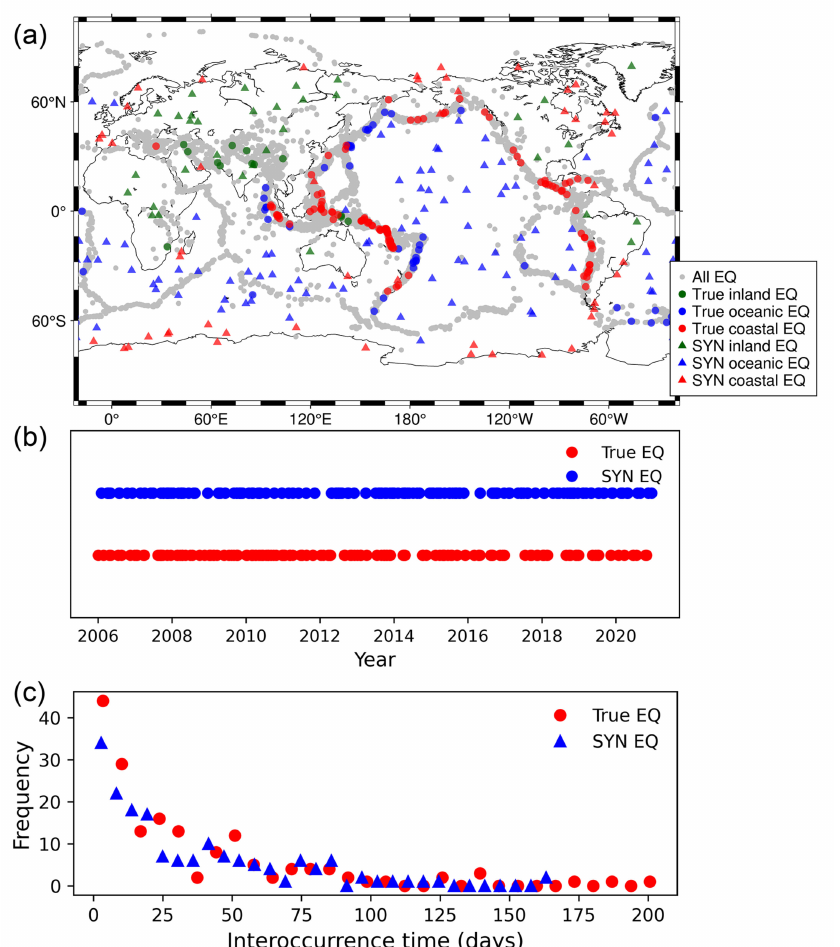
Figure 1. Characteristics of 169 global earthquakes (EQ) and 169 synthetic (SYN) earthquakes with magnitudes ≥ 7 and focal depths ≤ 70 km from 2006 to 2020. ( a ) Spatial distribution of both true and SYN EQs. The gray circles denote global 15,646 earthquakes with magnitudes ≥ 5.5 and focal depths ≤ 70 km from 1980 to 2020, representing global active seismic regions. ( b ) Temporal characteristics of EQ occurrences. ( c ) Statistics of interoccurrence time of both true and SYN